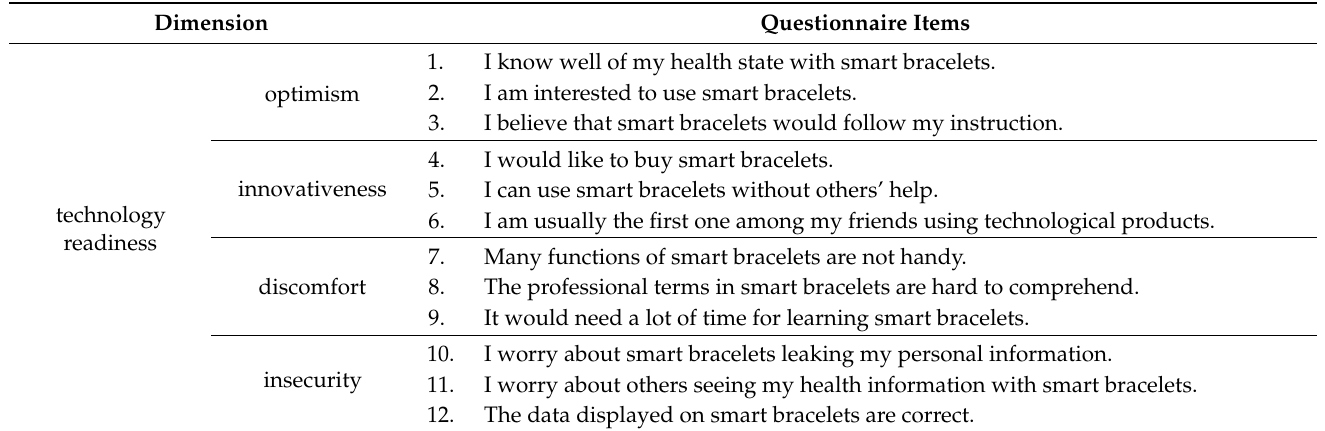
Table A1. The list of questionnaire